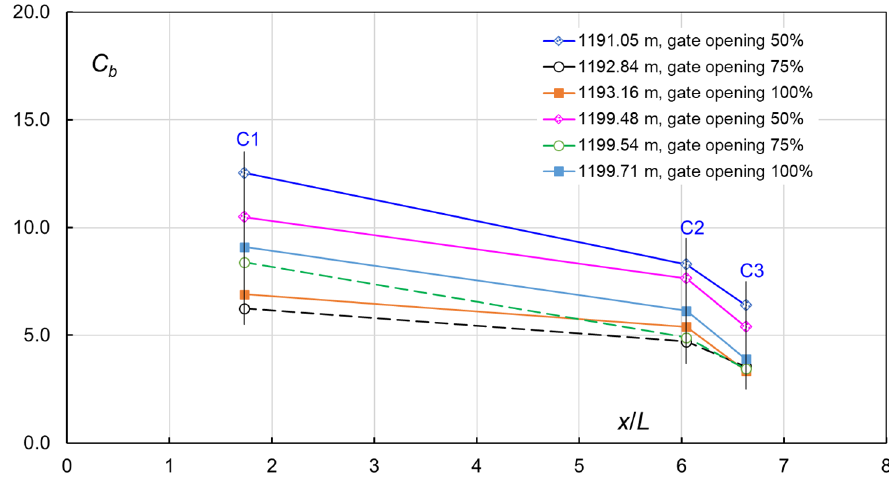
Figure 17. Prototype measurement results of C b at aerator no. 2 in Ertan flood discharge tunnel (based on the data in [12]).